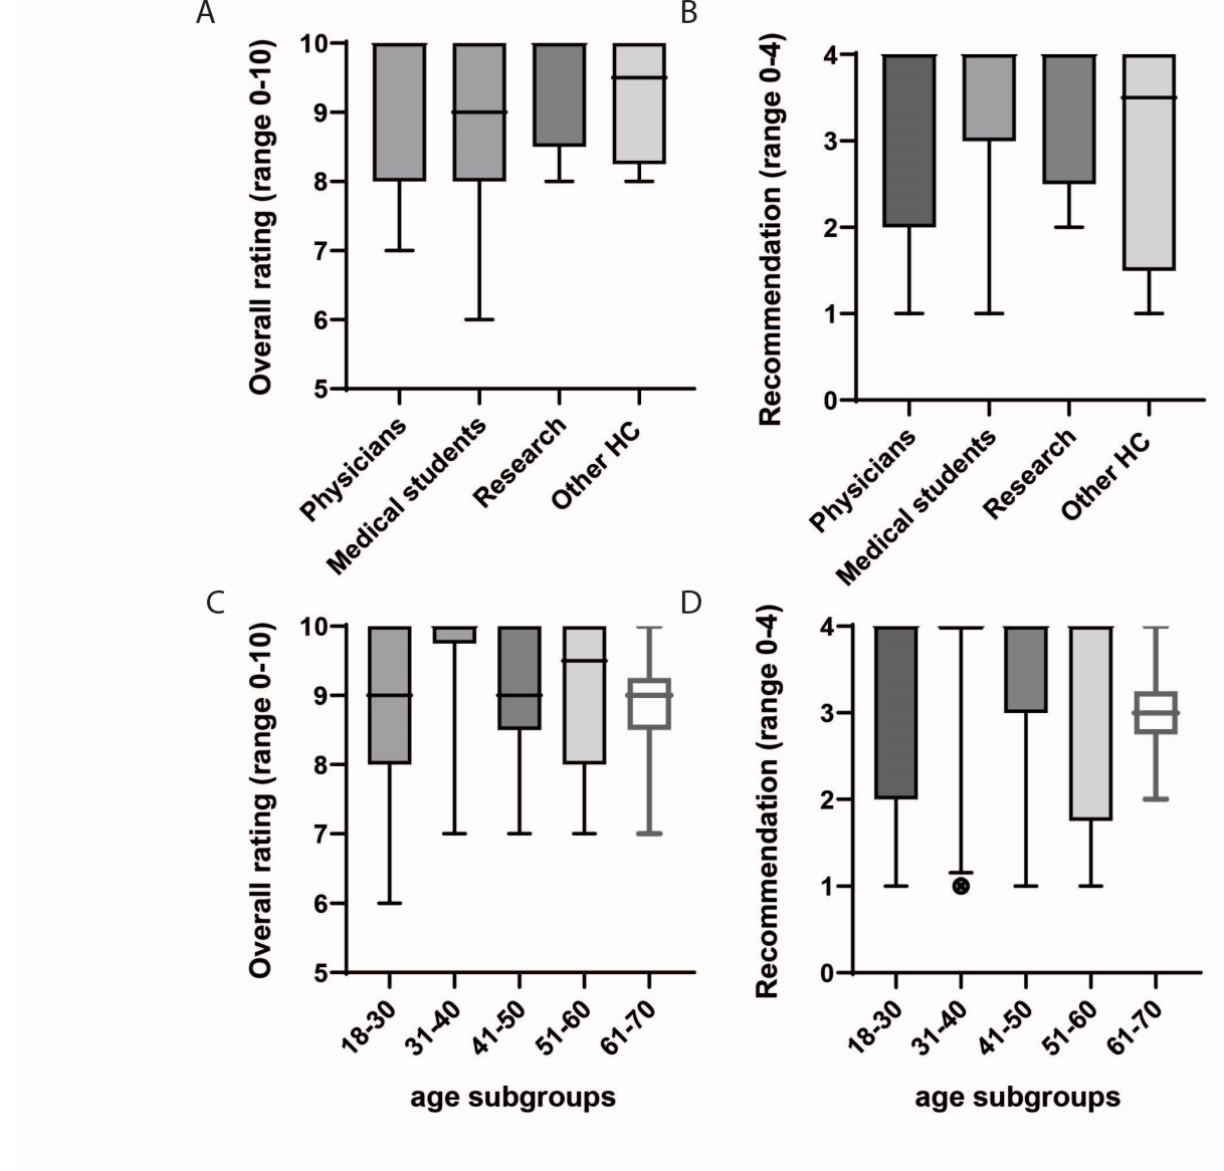
Figure 3. Feedback on the virtual reality (VR) app Rheumality. Overall rating (range 0-10) on the VR app divided into four different professional subgroups (A) and age subgroups (C). Recommendations of the VR app in the four different professional subgroups (B) and age subgroups (D) on a scale of 0 (not at all) to 4 (definitely). In the boxplots, crossbars represent medians, whiskers represent the 5th-95th percentiles (points below the whiskers are drawn as individual points); the box always extends from the 25th to 75th percentiles (hinges of the plot). HC: health care